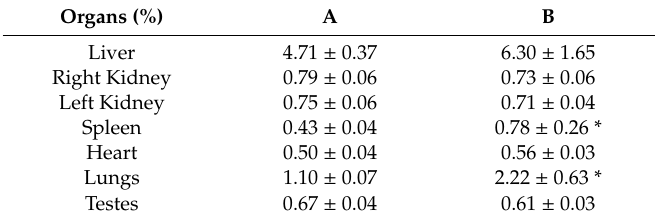
Table 1. The effects of ENU on relative organs’ weights in % (mean ± SEM) of male ICR-mice. Table 1. The e ff ects of ENU on relative organs’ weights in % (mean ± SEM) of male ICR-mice.